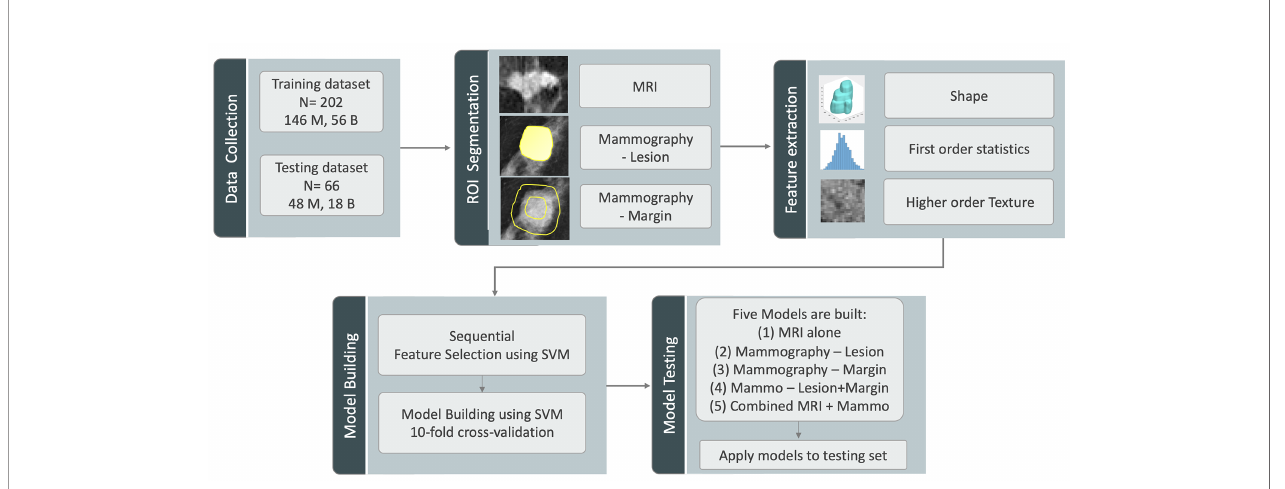
FIGURE 1 | The analysis fl owchart. The training and testing sets are assembled according to the time of case enrollment. The analysis starts with ROI segmentation, followed by radiomics feature extraction using Pyradiomics, feature selection and model building in the training set using SVM with cross-validation, and lastly, the testing of the 5 developed models in the testing